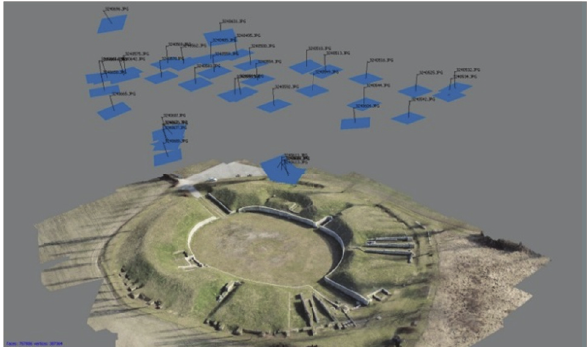
Figure 1. 3D vis Carnuntum